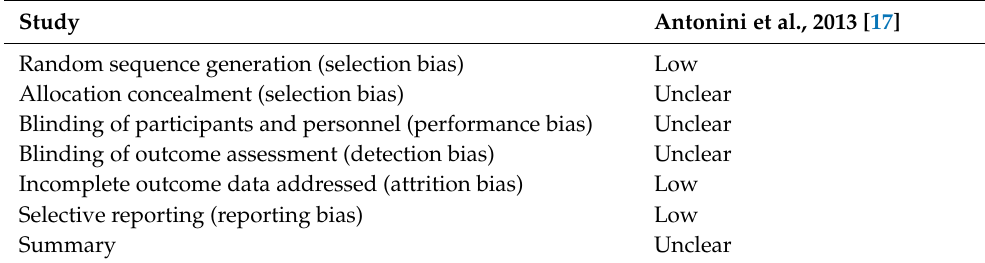
Table 6. Risk of bias of the randomized clinical